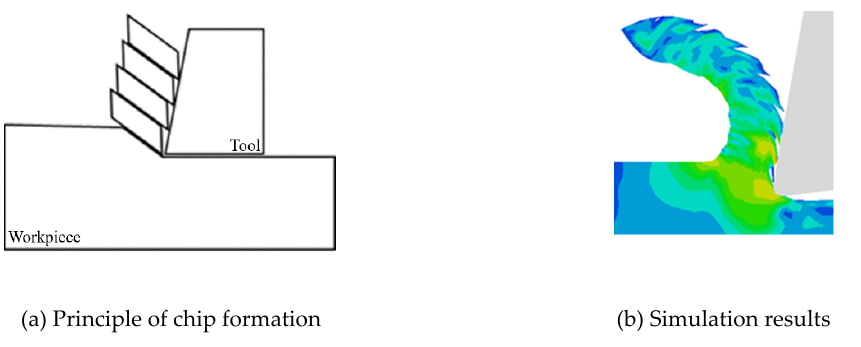
Figure 11. Formation of BMG chips. ( a ) Principle of chip formation; ( b ) simulation results.